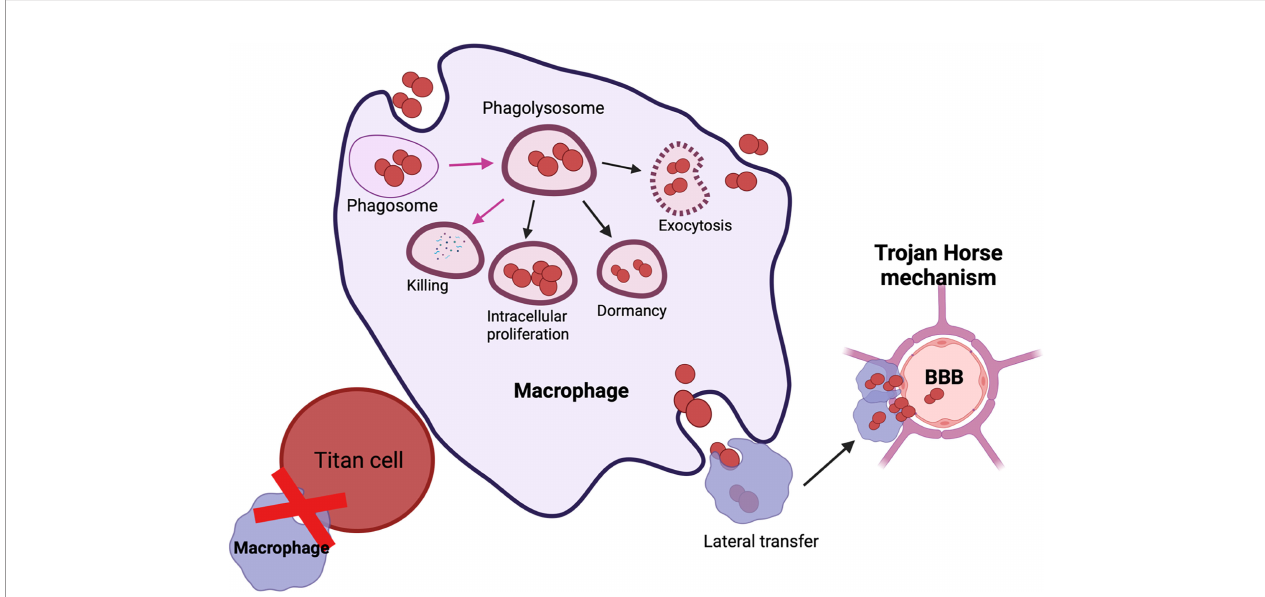
FIGURE 2 | Possible outcomes of C. neoformans -macrophage interaction: Engulfment of C. neoformans results in containment within the phagolysosome and C. neoformans killing (shown in pink arrows). C. neoformans has multiple methods of interacting with host immune responses which include: (i) Intra-cellular proliferation, (ii) Dormant/latent, (iv) Titanization or exiting the macrophage via (A) exocytosis or (B) lateral transfer. Lateral transfer can also contribute to the dissemination of C. neoformans to the brain via Trojan horse